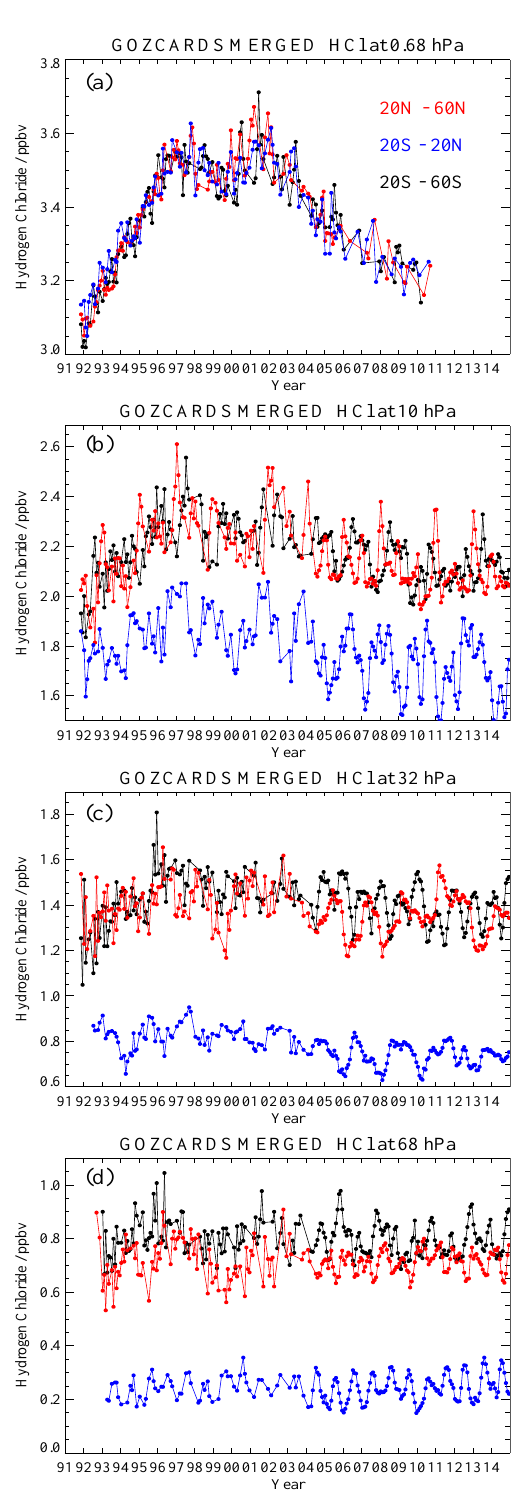
Figure 7. Time series of the GOZCARDS monthly averaged merged HCl abundance for three different latitude bin averages (see color legend in panel a ) for (a) 0.7hPa, (b) 10hPa, (c) 32hPa, and (d) 68hPa.